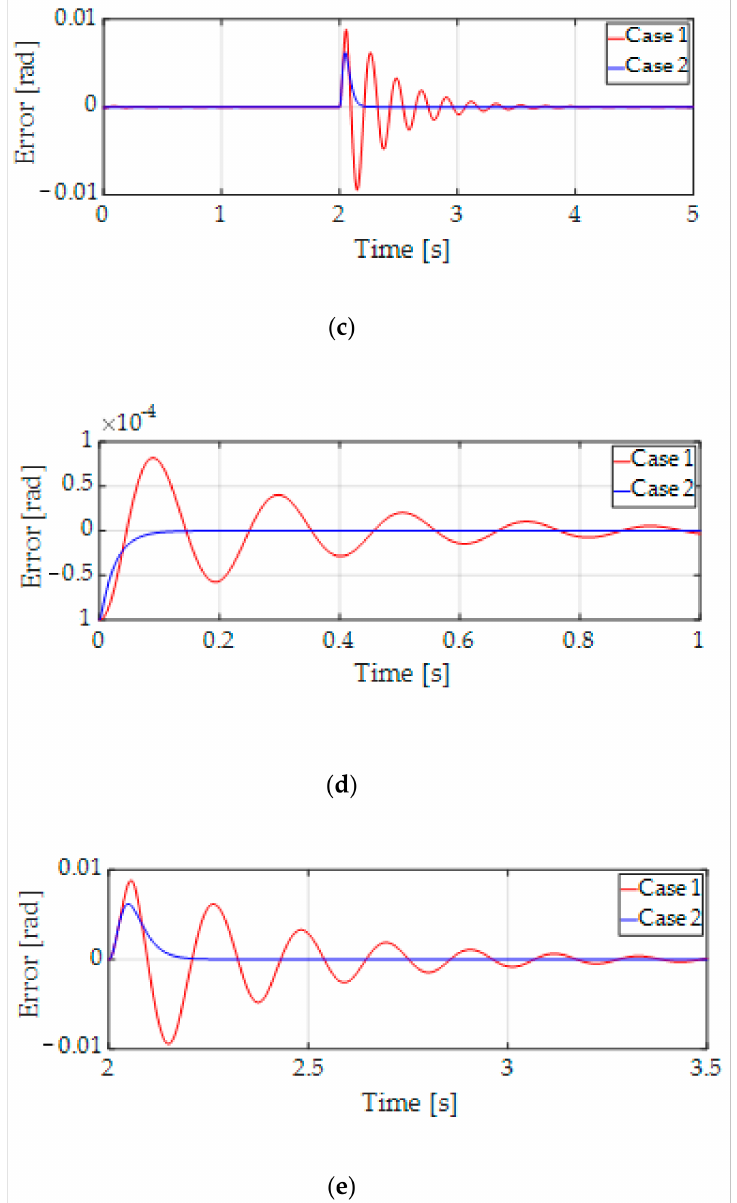
Figure 8. Position and yaw tracking errors. ( a ) X-axis position tracking error of e θ tracking error of e θ ( e ) Zoom-in X-axis at 2 s of e θ